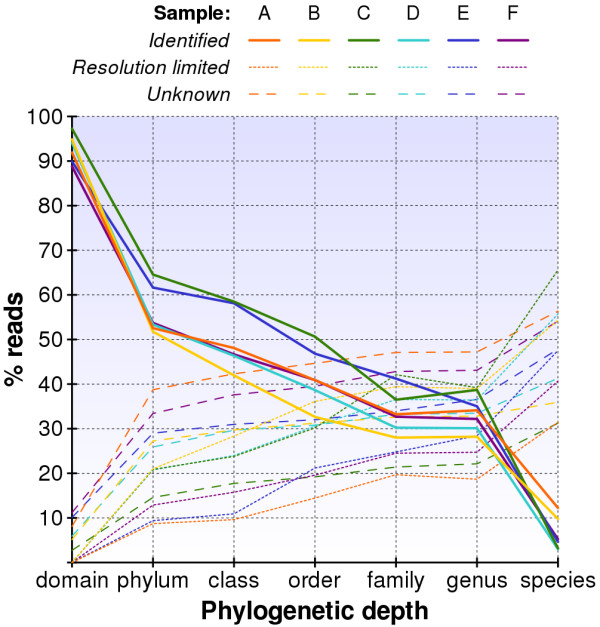
Read resolution within phylogenetic tree for samples. Individual categorization of reads in six samples into their proportion of reads identified (solid line)/resolution limited (dotted line)/unknown (dashed line).